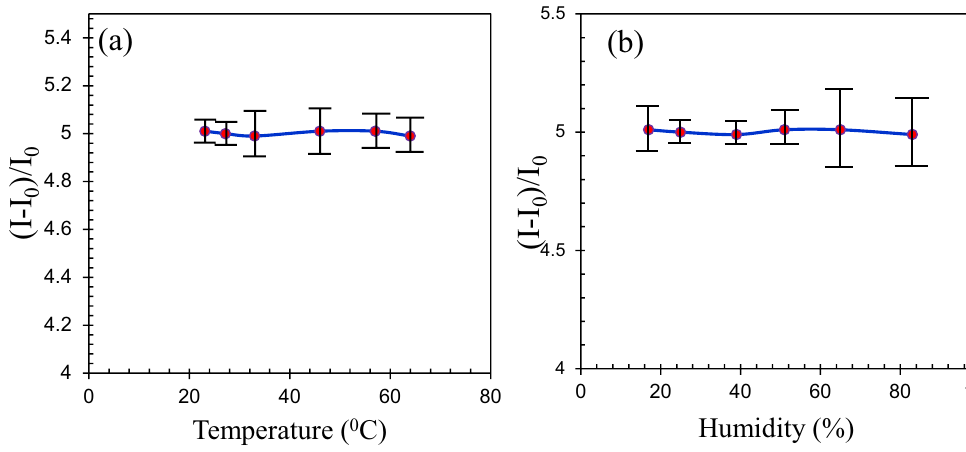
Figure 14. Effect of ( a ) temperature and ( b ) humidity on the sensor performance in response to 5 nM